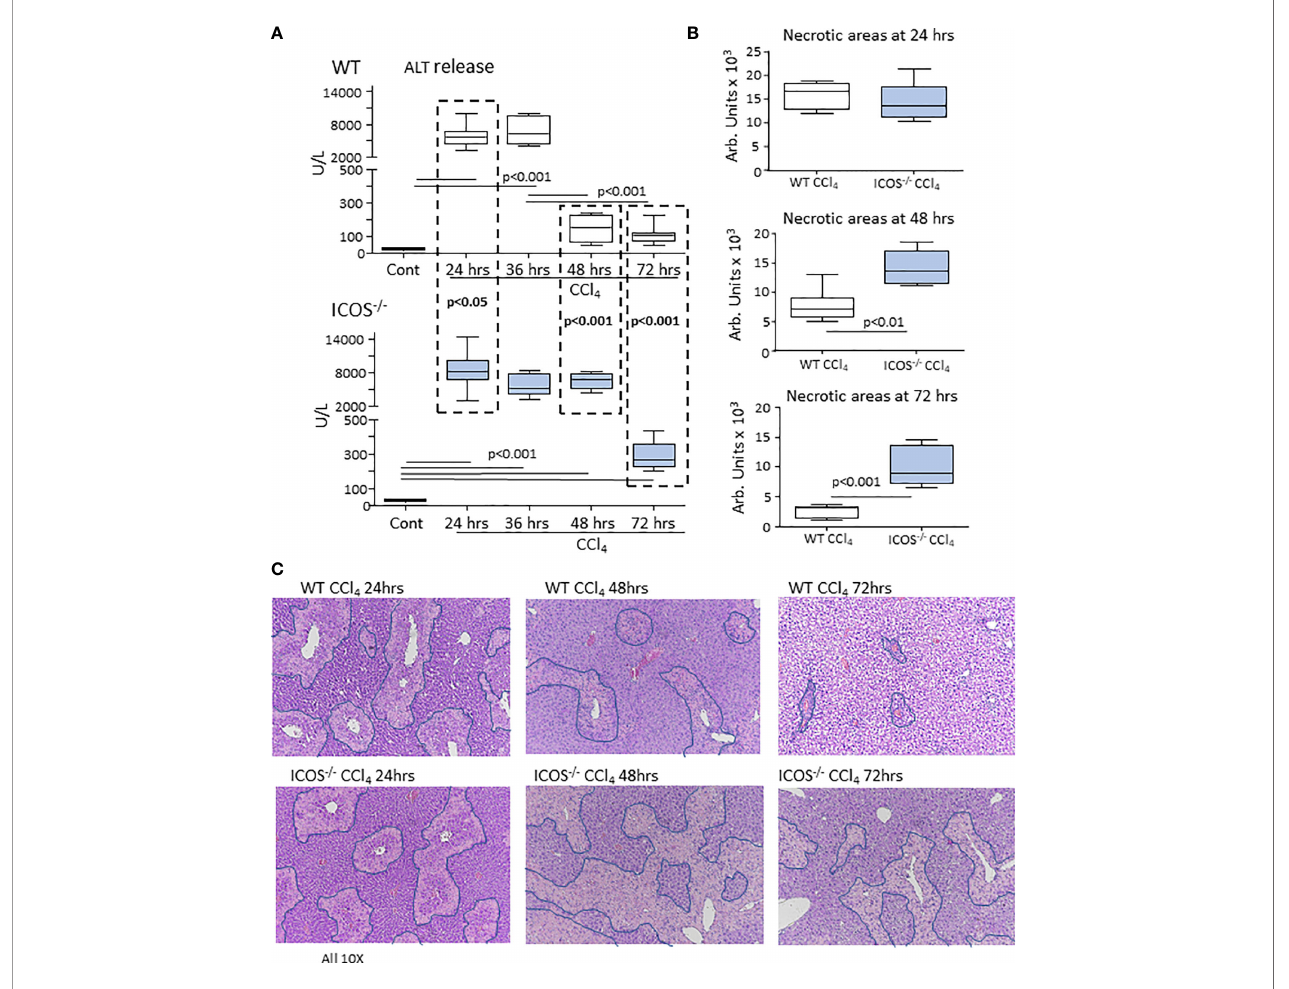
FIGURE 3 | ICOS de fi ciency impairs the resolution of acute liver injury. The evolution of acute liver injury induced by the administration of CCl 4 in wild-type and ICOS -/- mice was monitored by measuring alanine aminotransferase (ALT) release (A) and by morphometric evaluation of necrotic areas (encircled by blue lines) in liver sections stained with hematoxylin/eosin (magni fi cation 10X) (B, C) . The results are expressed as mean ± SD of 5-8 animals for each time